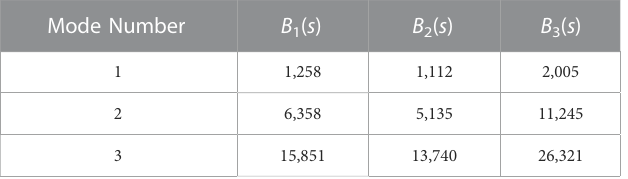
TABLE 2 Critical fl ow strengths representing the onset of instability ( σ =0) for the fi rst three modes for each rigidity pro fi le. Mode